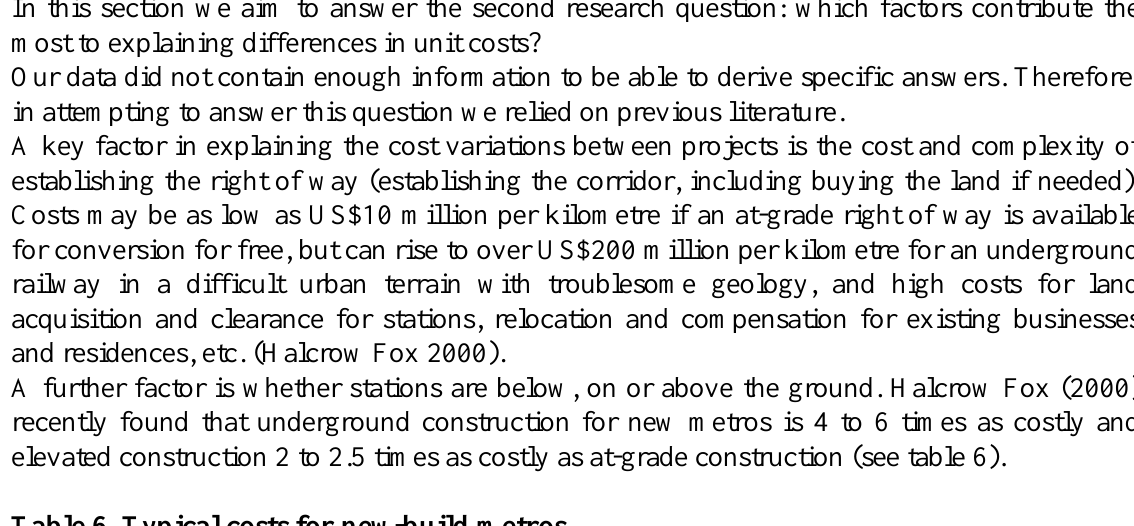
Table 6. Typical costs for new-build metros.